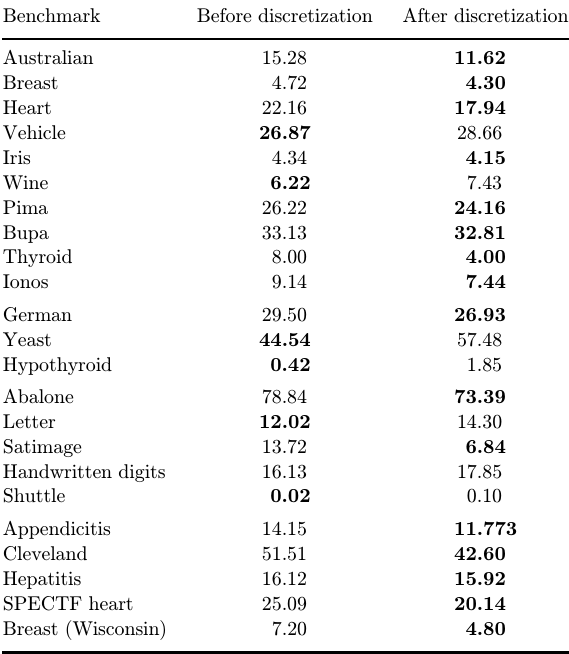
Table 5. Error rate before and after discretization under LR-Discr.